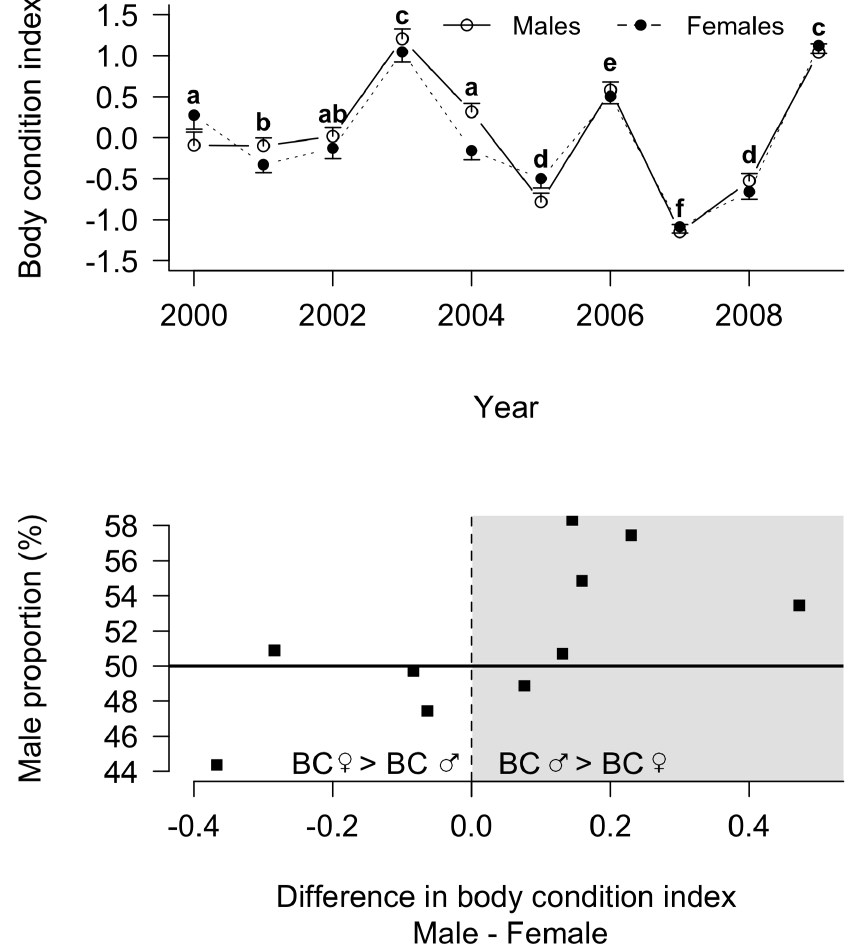
Figure 4. Yearly changes in male and female fledging body condition (BC; panel A) and yearly sex ratio at fledging according to fledging BC difference between males and females (panel B) in king penguins. Panel A: male and female body conditions are given as solid line, open circles and dotted line, full circles, respectively. Letters in superscript indicate differences between years in the average (male and female) body condition. Average values not sharing a common superscript are different for P , 0.05. Panel B: the grey area corresponds to the years in which male body condition is higher than female body condition, while the white area presents the opposite. Note that the horizontal solid line indicates the balanced sex ratio at fledging. Every point situated above corresponds to a higher proportion of males, while below corresponds to a higher proportion of